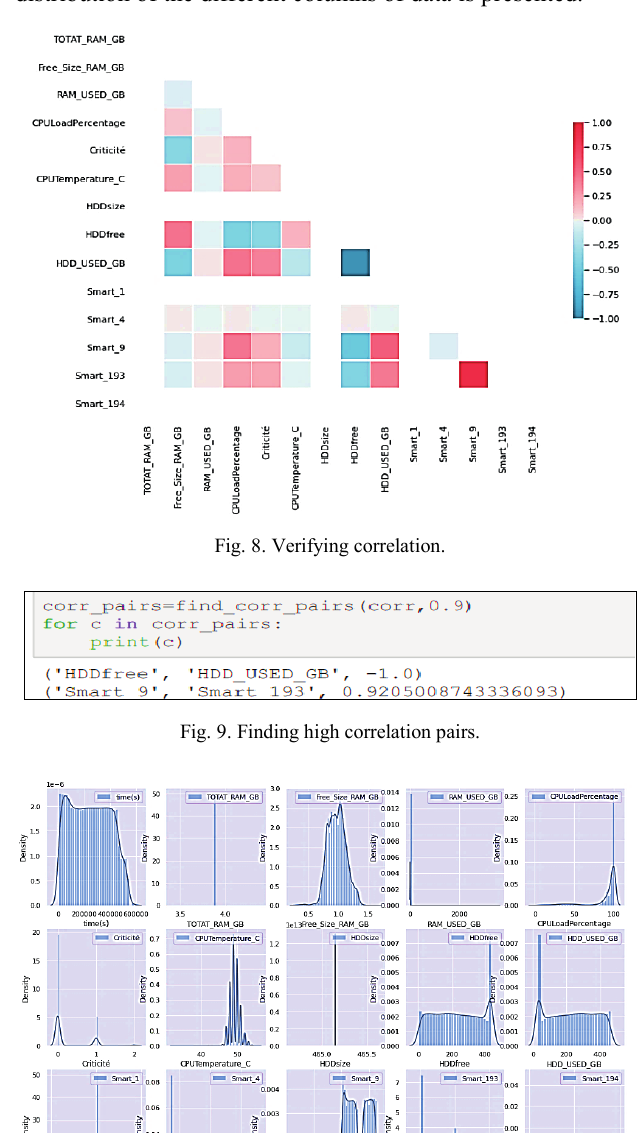
Fig. 7. Display of data on Python notebook.